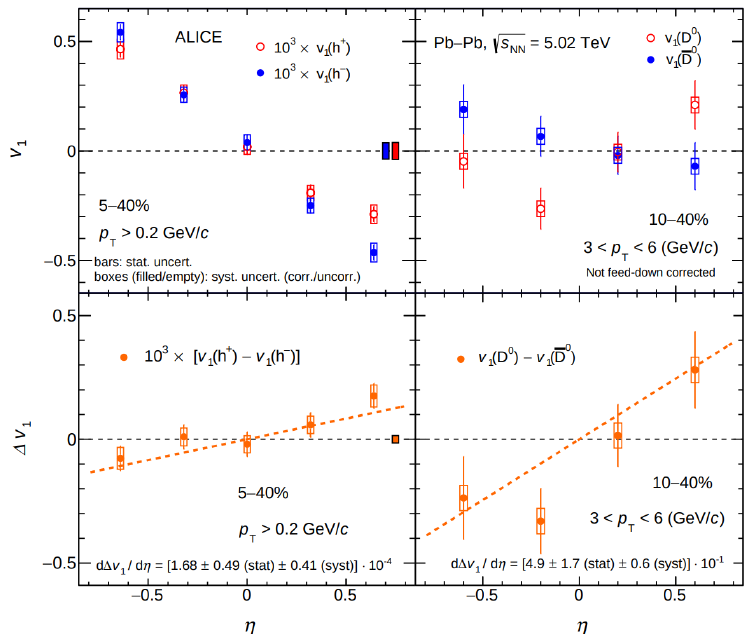
Figure 1: Results from ALICE is chosen to be shown here. Upper left: v 1 of positively (red) and negatively (blue) charged hadrons for the 5–40% centrality interval; upper right: v 1 of D 0 (red) and ¯ D 0 (blue) for the 10–40% centrality interval; lower left and right: ∆ v 1 ( h ) = v 1 ( h + ) − v 1 ( h − ) and ∆ v 1 ( D ) = v 1 ( D 0 ) − v 1 ( ¯ D 0 ), respectively. Dashed lines represent fits with a linear function